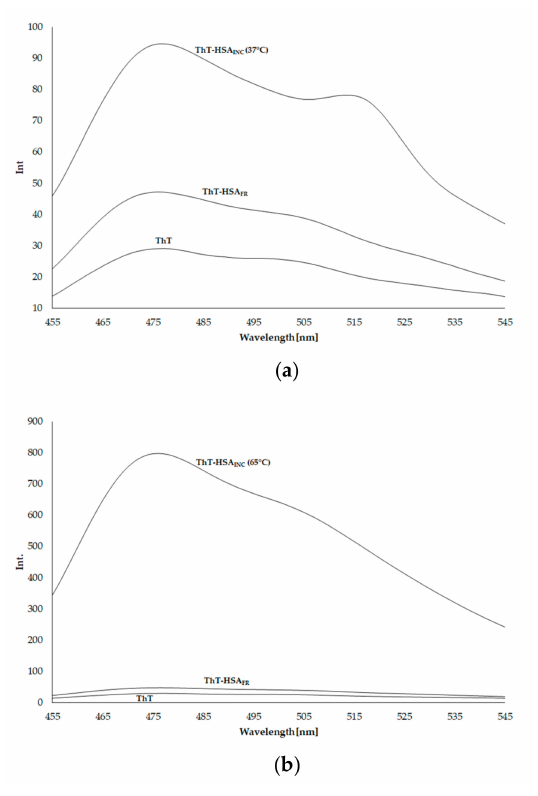
Figure 1. Emission fluorescence spectra of thioflavin T (ThT) (1 × 10 − 5 mol · L − 1 ) in the presence of unmodified human serum albumin (HSA FR ) and incubated human serum albumin (HSA INC ) at ( a ) 37 ◦ C for 9 days and ( b ) 65 ◦ C for 7 days; HSA concentration 1 × 10 − 6 mol · L − 1 , λ ex 440 nm. α -helical HSA with destabilized conformation at 65 ◦ C forms fibrils. HSA fibrils are also